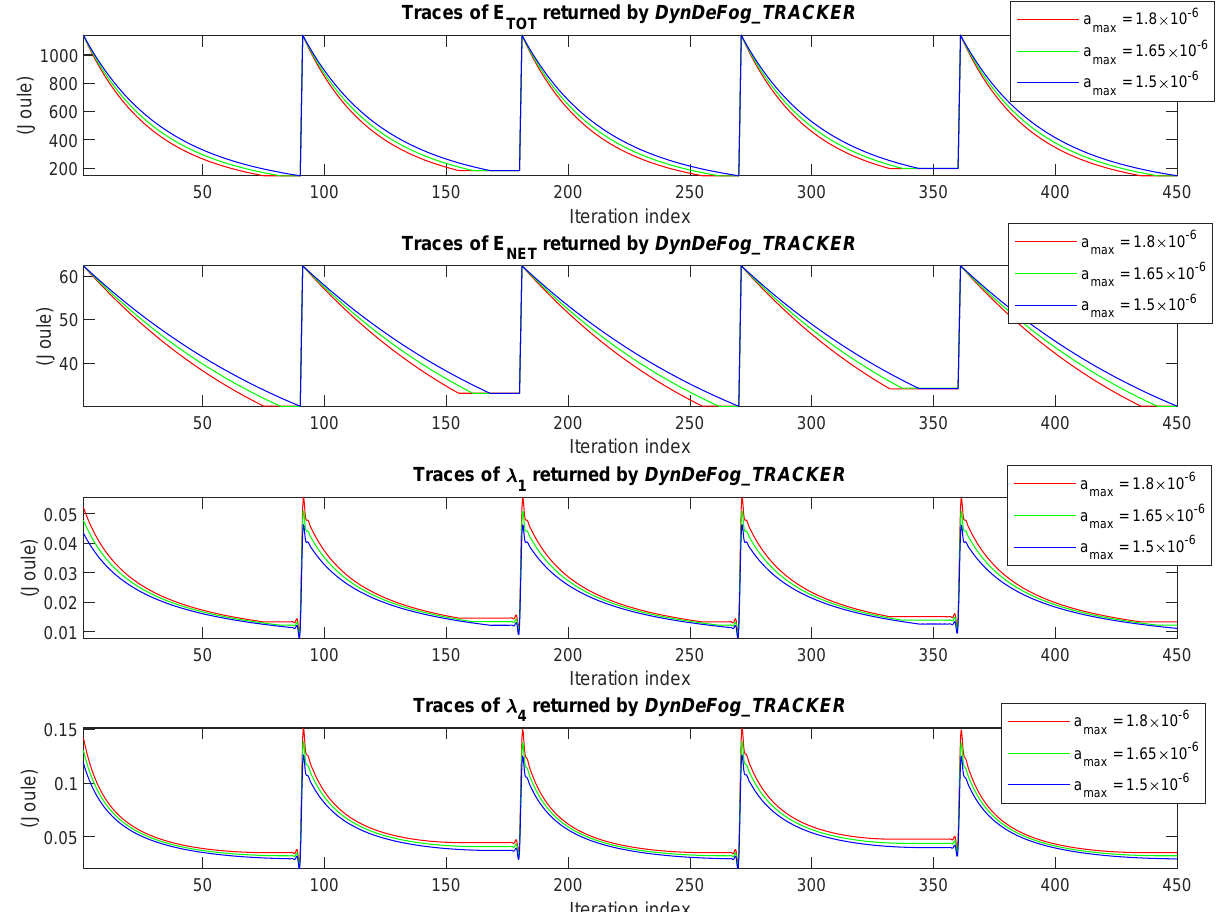
Figure 16. Tracking performance of DynDeFog_TRACKER under the sequential failure of nodes Fog ( 1,3 ) and Fog ( 4,2 ) of topology T